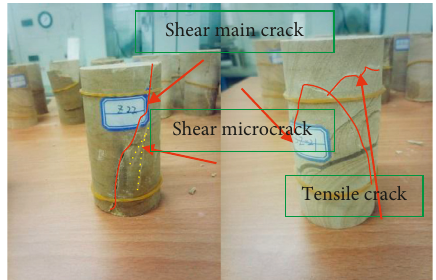
Figure 12: Fracture morphology by sz-22 and sz-21.